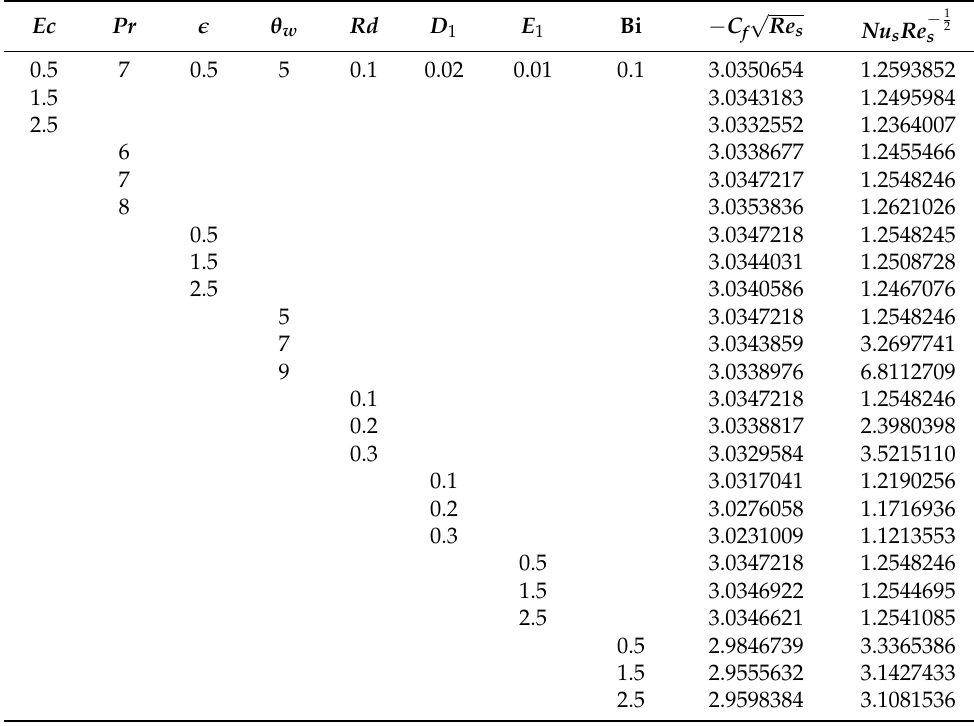
Table 3. Effects of the values of numerous parameters on − C f